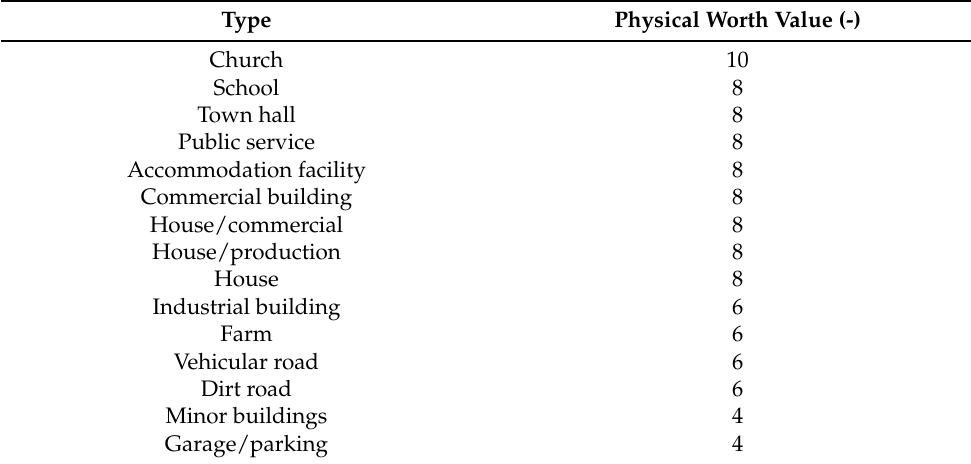
Table 2. Physical worth values used in the risk